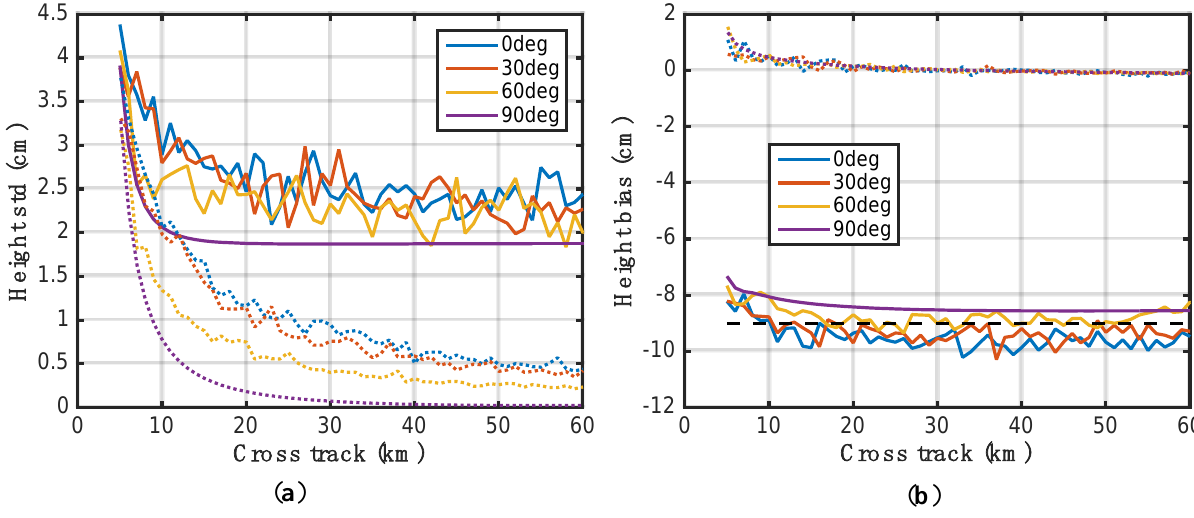
Figure 5. Height standard deviation ( a ) and mean bias ( b ) for a 3 m SWH unidirectional ocean wave field with the Pierson-Moskowitz spectrum for various directions relative to the boresight (0 deg is aligned with boresight, 90 deg is in the along-track direction) computed using radar simulations for the SWOT geometry, radar parameters, and on board radar processing. Solid is for 𝛽 = 3% and tilt modulation, and dotted is for no backscattering modulation. The dashed black line in ( b ) corresponds to the theoretical EM bias in Equation